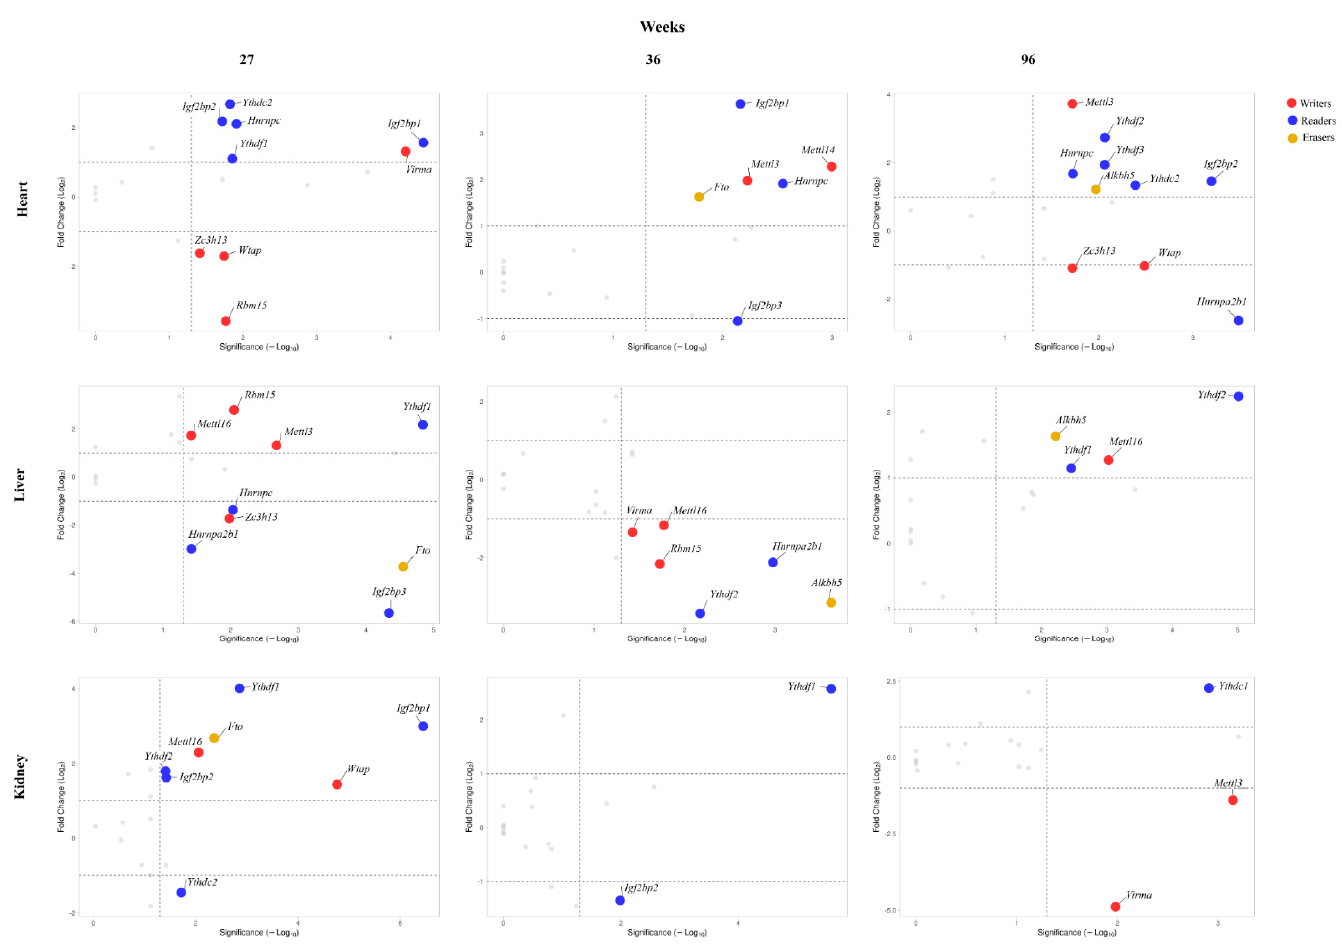
Figure 3. Changes in the expression of writer, reader, and eraser genes in the heart, liver, and kidney from rats according to diet for each analyzed age. The values are reported as log 2 FC (fold change) calculated as the ratio of the mRNA levels between low-calorie and standard diet at 27, 36, and 96 weeks of age. Scattered points represent all the analyzed genes; red, blue, and yellow dots represent writer, reader, and eraser genes, respectively, that encounter significant differences in levels of expression with age. Grey dots represent unregulated genes. The x-axis represents the Bonferroni p -value adjusted in − log 10 format, the y-axis shows log 2 ratio of gene expression levels between standard and low-calorie diet. The dotted lines represent Bonferroni cut-off ( p -values < 0.05) and the two-fold